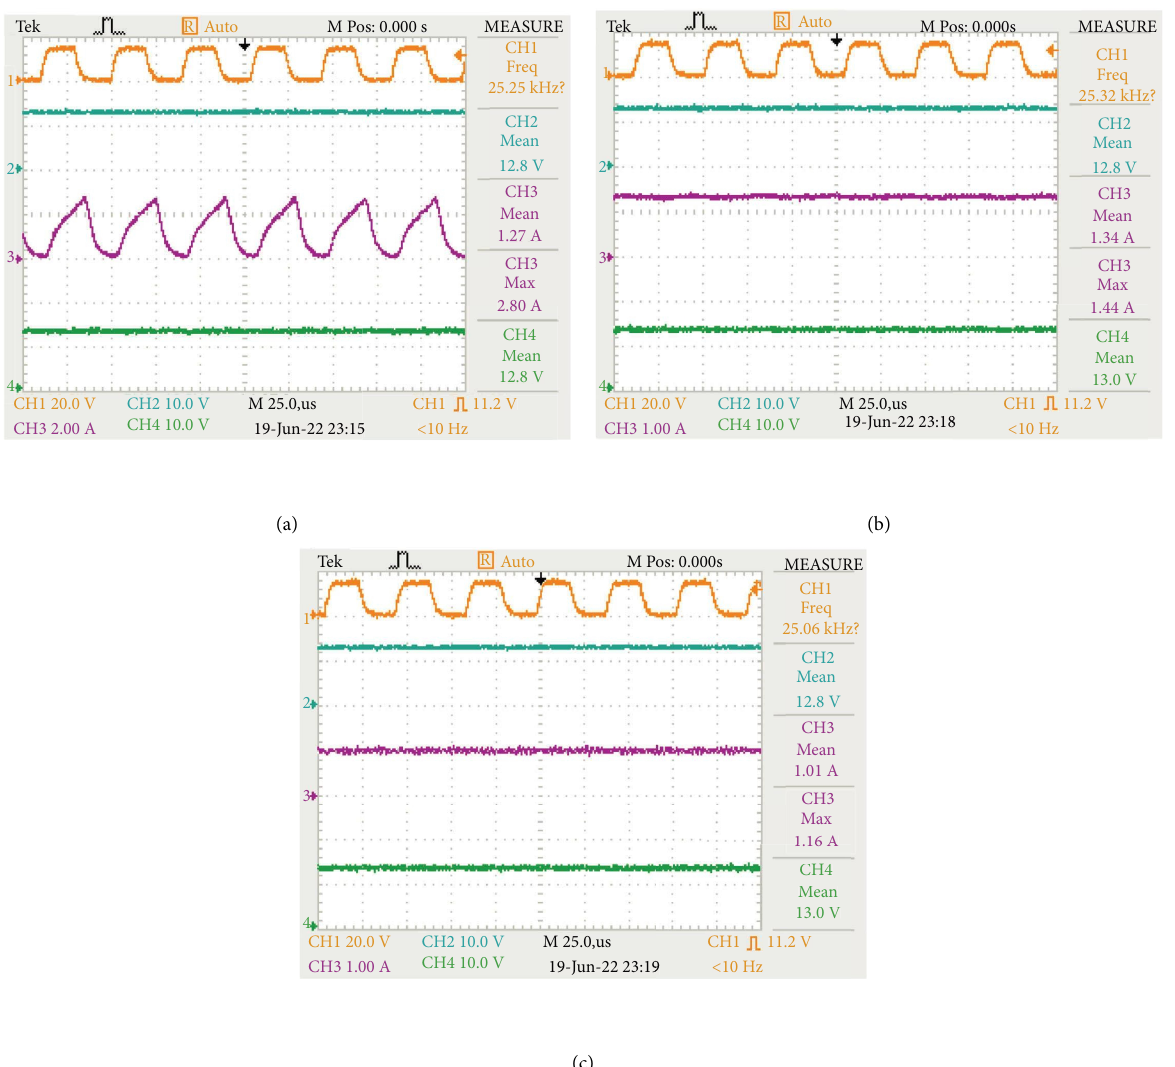
Figure 16: (a) PWM, V